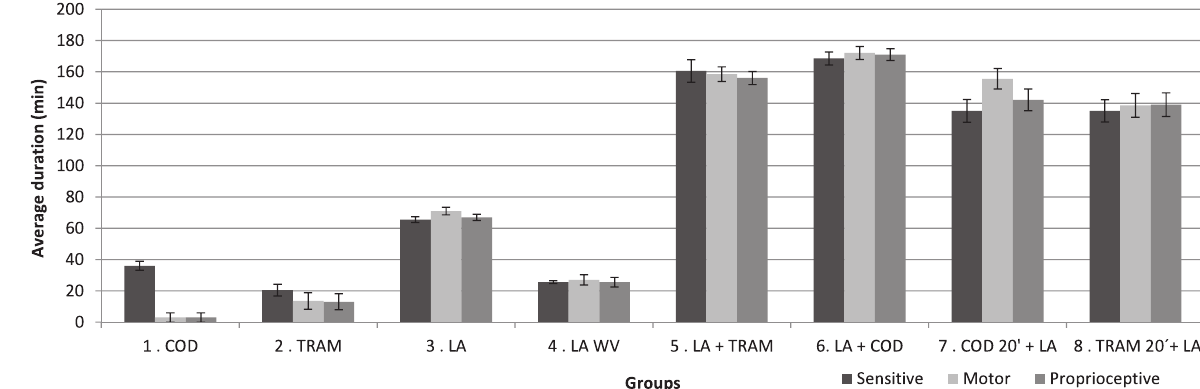
Figure 2 - Mean duration